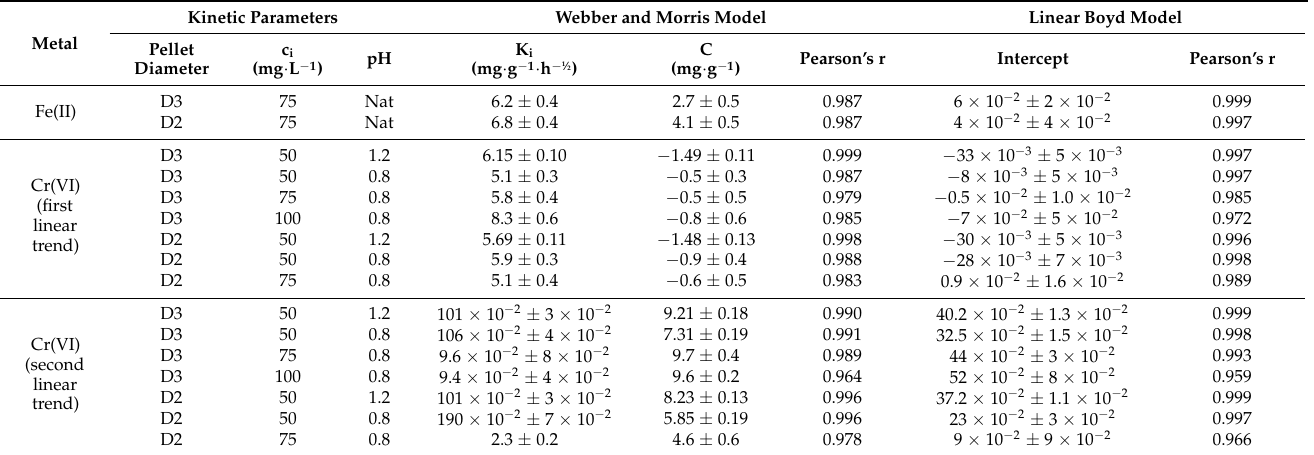
Table 2. Kinetic parameters obtained using the diffusion models for Fe(II) sorption and Cr(VI)